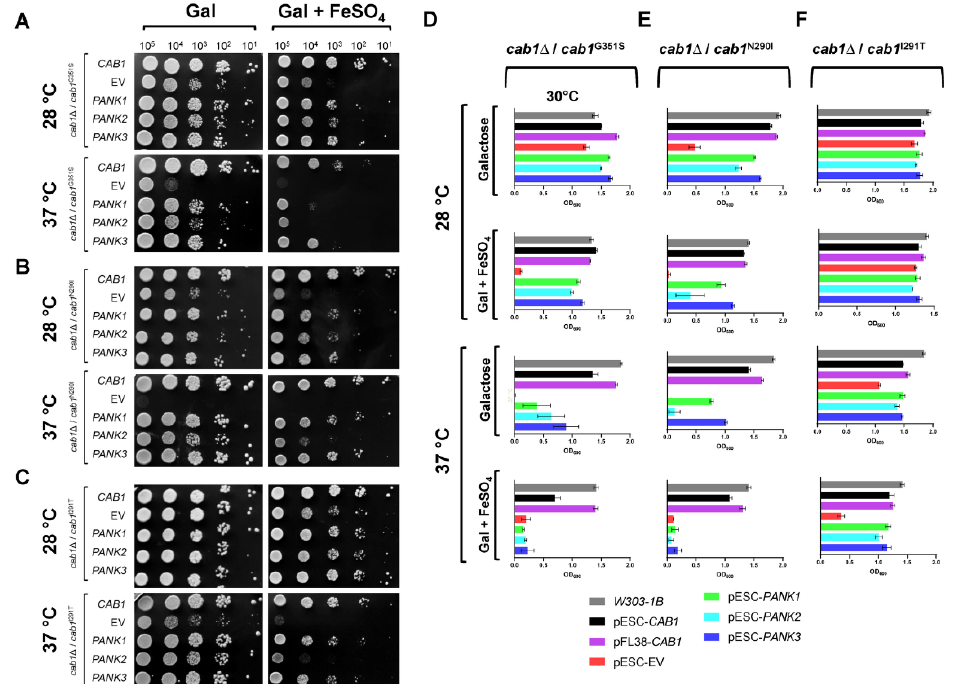
Figure 4. Human PANK1–3 complement iron sensitivity of yeast strains with defective PanK